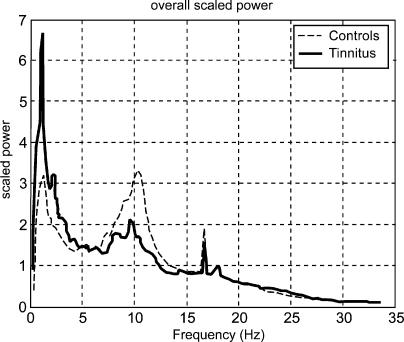
Power Spectra Averaged over All Sensors Show a Reduced Alpha Peak in Participants with Tinnitus and an Enhancement for DeltaThe sharp peak centred at 16 2/3 Hz represents technical noise resulting from the 1-km-distant railway system.